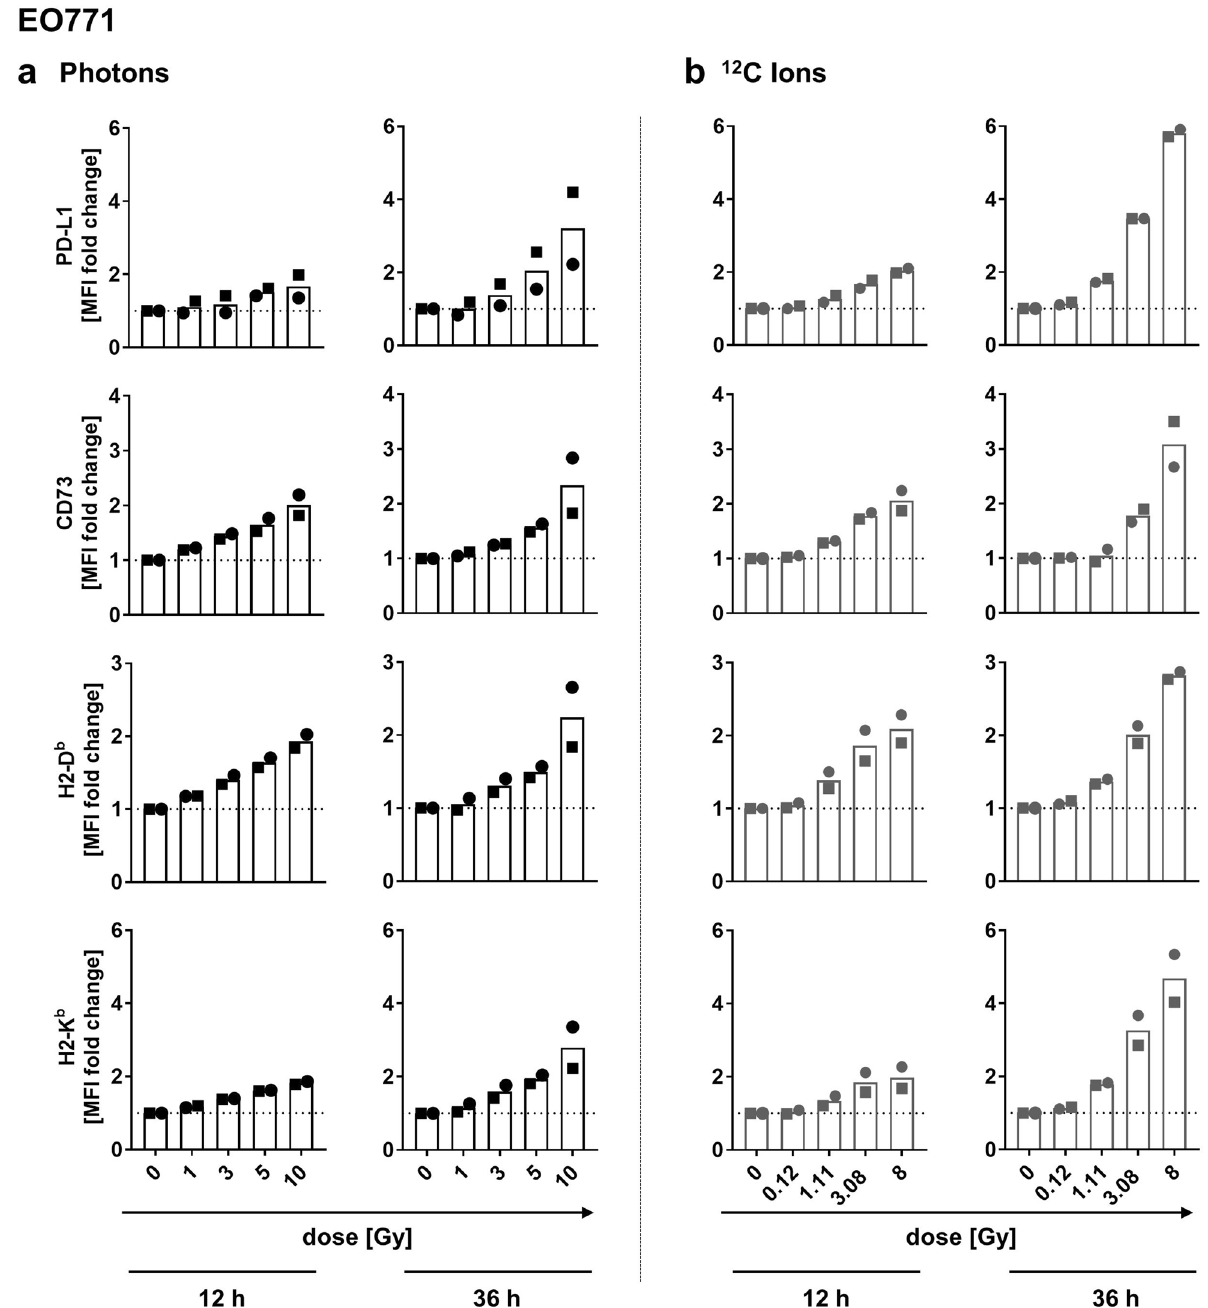
Figure 3. Cell surface expression of immunomodulatory molecules on EO771 cells irradiated with photons or carbon ions. Flow cytometric analysis of PD-L1, CD73 and MHC-I cell surface expression on EO771 cells 12 and 36 h after irradiation with graded doses of photons ( a ) or biologically equivalent doses of carbon ions ( b ). Depicted are fold changes of MFI (mean fluorescence intensity) normalized to MFI of non-irradiated cells. At least 40,000 viable cells were acquired per sample. Results of two experiments performed are shown (squares: experiment 1; dots: experiment of carbon ion irradiated PDA30364/OVA cells to OVA-specific CTL lysis through impedance-based cytotoxicity assays (xCELLigence assay). Applying biologically equivalent doses of carbon ions, we found that irradiation induced enhanced killing of target cells in a dose-dependent manner, resulting in earlier onset of cytolysis of irradiated cells compared to non-irradiated control. This effect became evident upon irradiation with 0.4 Gy carbon ions and increased with higher doses (Fig. 5a). In fact, irradiation with 3.1 Gy carbon ions, which is equivalent to 10 Gy photons, resulted in a significant increase in cytolysis compared to untreated cells persisting for 18 h following CTL co-culture (Fig. 5a).